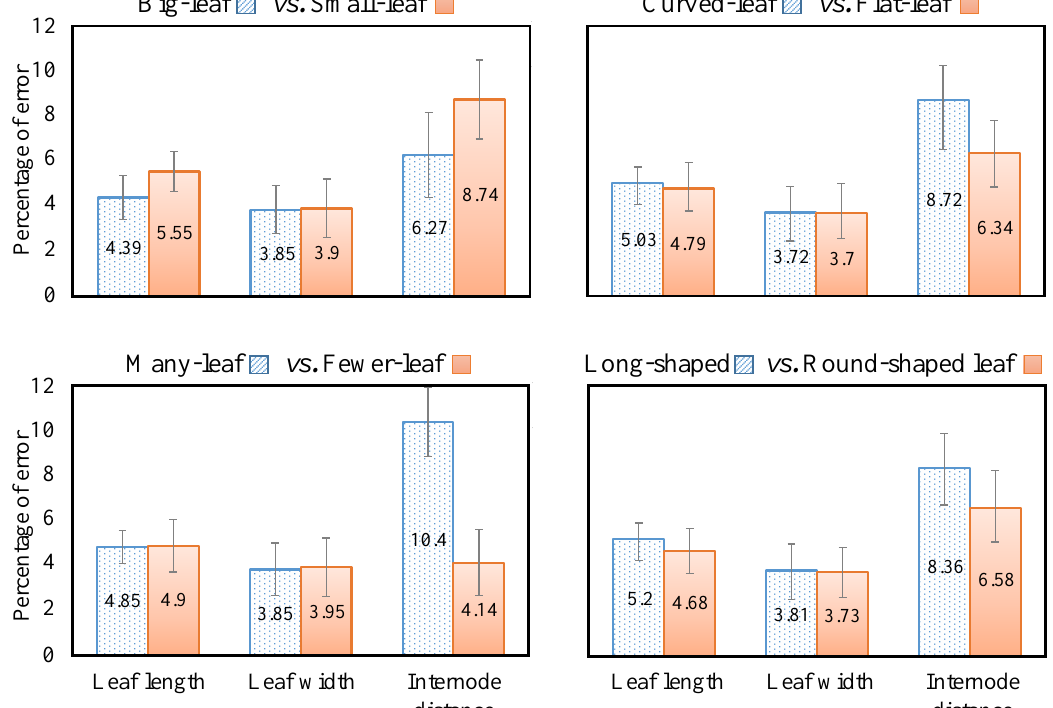
Figure 14. Comparison of the percentage of error in plant height estimation for plants having different leaf sizes, leaf shapes and numbers of leaves. Errors for leaf length, leaf width and internode distance were considered in order to understand which types of plant leaves yield higher errors. From left to right, top to bottom: plants having big leaves versus plants having small leaves, plants having curved versus flat leaves, plants having many versus fewer leaves and plants having long-shaped versus round-shaped